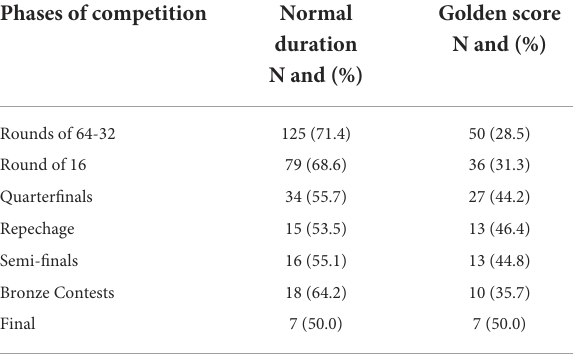
TABLE 2 Distribution of matches duration (regular and golden scores) and phases of competition during the Tokyo 2020 Olympic Games.